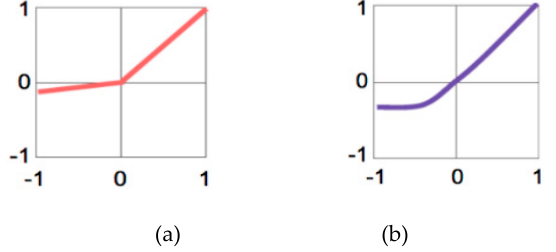
Figure 24. Diagram for ( a ) Leaky ReLU (Rectified Linear Unit), and ( b ) Exponential Linear Unit (ELU). Electronics 2019 , 8 , x FOR PEER REVIEW